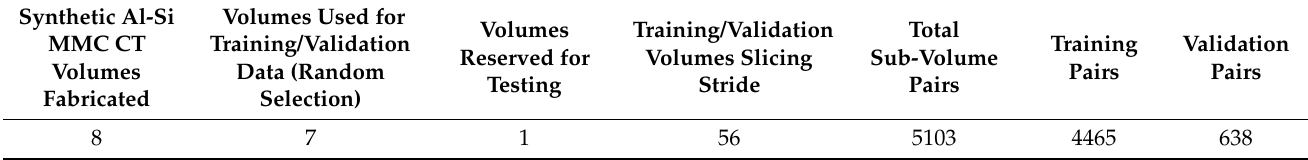
Table 1. Training and validation data